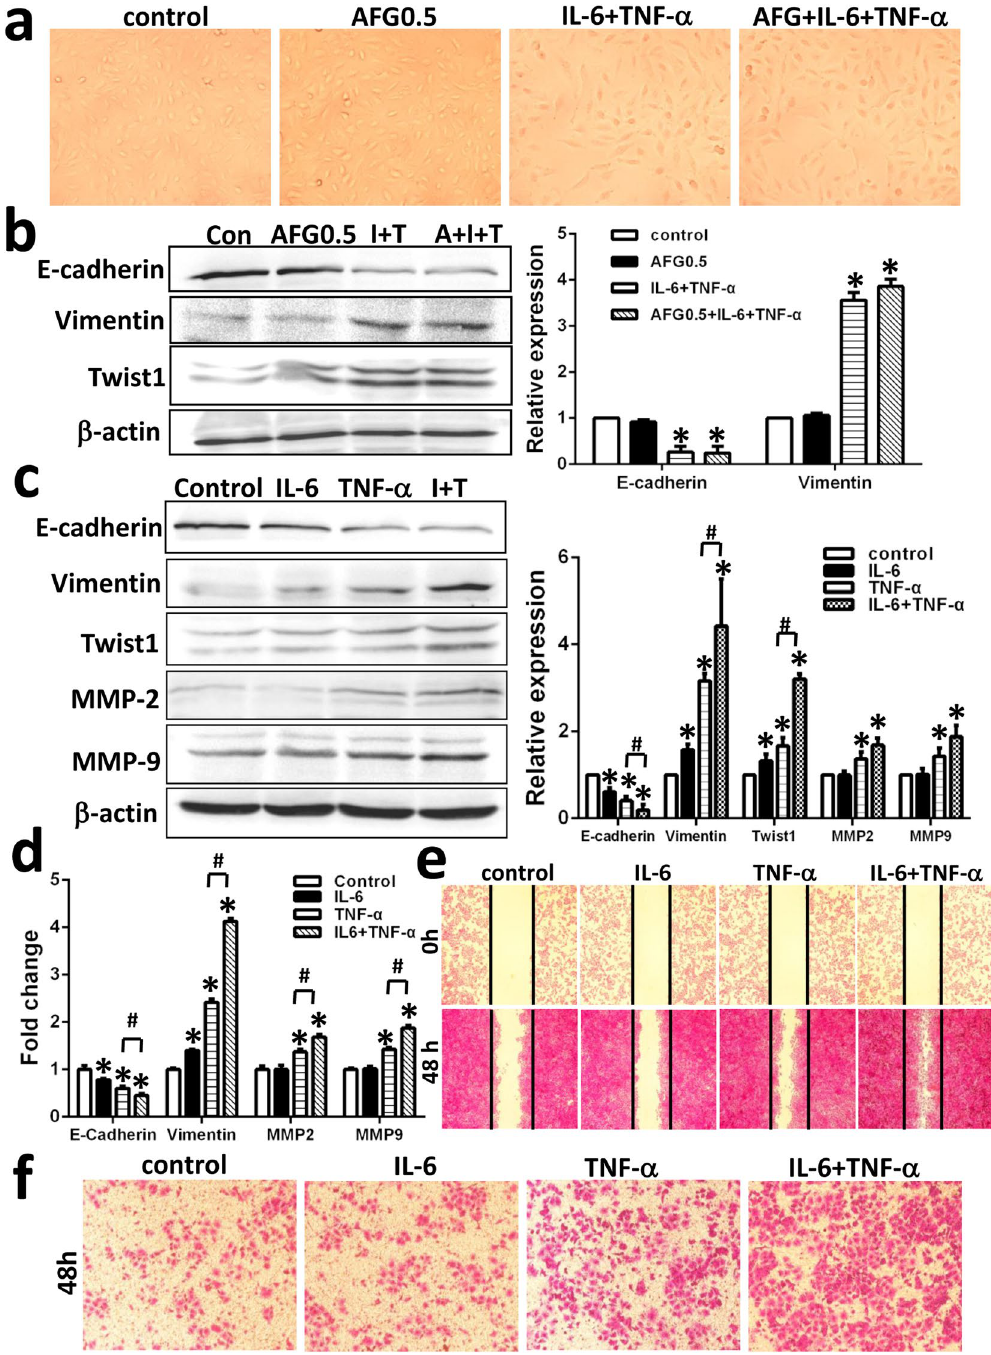
Figure 5. TNF- α working with IL-6, not AFG 1 , induced EMT and migration in lung cancer cells. A549 cell were treated with AFG 1 and/or TNF- α plus IL-6 for 72 hours. ( a ) Morphological changes of A549 cell was observed under light microscopy. ( b ) The expression of E-cadherin, vimentin and twist1 in A549 cell was detected by Western blot. Band intensity is coming from densitometry, and data was shown as mean ± SD (three experiments, * p < 0.05, compared to control). A549 cells were treated with TNF- α , IL-6, or TNF- α plus IL-6 for 72 hours. The expression of E-cadherin, vimentin, twist1, MMP2 and MMP9 in A549 cell was detected by Western blot ( c ) and qPCR ( d ). Data was shown as mean ± SD (three experiments, * p < 0.05, compared to control group; # p < 0.05, compared to TNF- α alone). After 48 h treatment, the migration ability of A549 cell was measured by wound healing migration assay ( e ) and transwell migration assay ( f